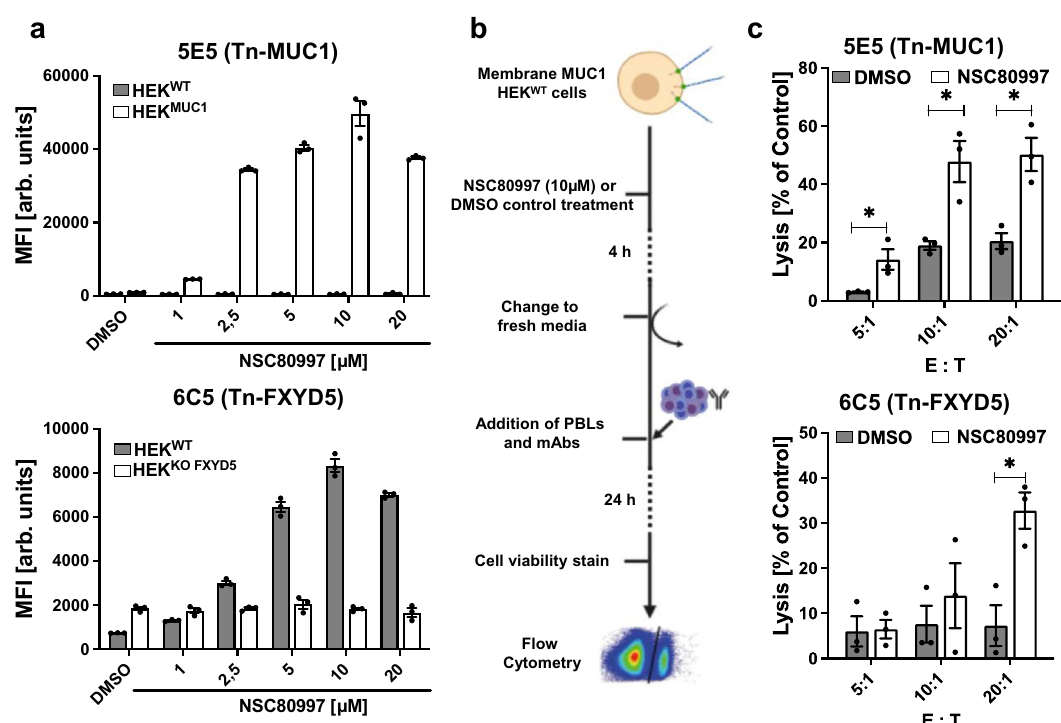
Fig. 6 | NSC80997 boosts antibody-dependent cellular cytotoxicity (ADCC) of Tn-speci fi c mAbs 6C5 and 5E5. a Cell surface binding of mAbs 5E5 (top) and 6C5 (bottom) to HEK WT , HEK KO FXYD5 cells, and HEK WT cells stably expressing membrane MUC1 reporter protein (HEK MUC1 ) treated with increasing concentrations of NSC80997 for 24h. Antibody binding wasmeasured by fl owcytometryand data is shown as mean MFI±SEM (arbitrary units) of three independent experiments. b Schematic illustration of ADCC assay. HEK MUC1 cells were treated with 10 µ M NSC80997 or DMSO for 4h, washed, and re-seeded. Monoclonal antibodies directed against Tn-MUC1 (5E5) and Tn-FXYD5 (6C5) were added to the HEK cells